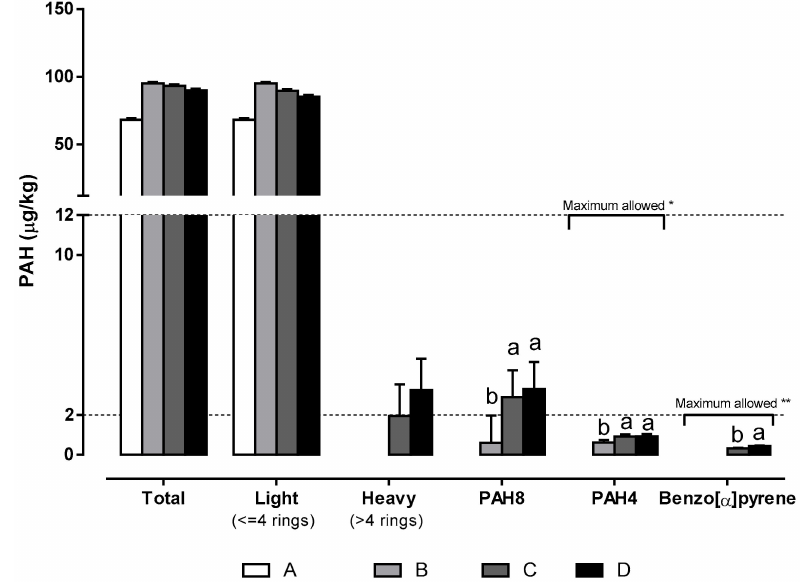
Figure 1. Polycyclic aromatic hydrocarbons (PAHs) ( µ g / kg wet weight) present in dry-cured sausages under di ff erent smoking regimes. Di ff erent letters for each group of PAHs represent significantly di ff erent means. * Maximum value of PAH4 allowed: 12 µ g / kg; ** Maximum value of Benzo[ α ]pyrene allowed: 2 µ g / kg. ( A ) no smoking; ( B ) 20 h e ff ective smoking; ( C ) 60 h e ff ective smoking; ( D ) e ff ective smoking until reaching 38%–40% weight